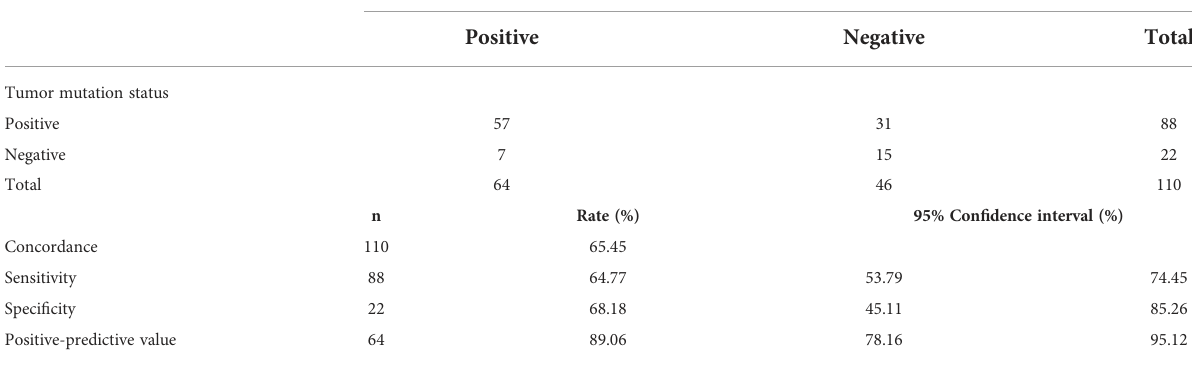
TABLE 3 Concordance, speci fi city, sensitivity and positive predictive value calculations for FFPE tDNA and paired PLA ctDNA samples in the NSCLC sub-cohort